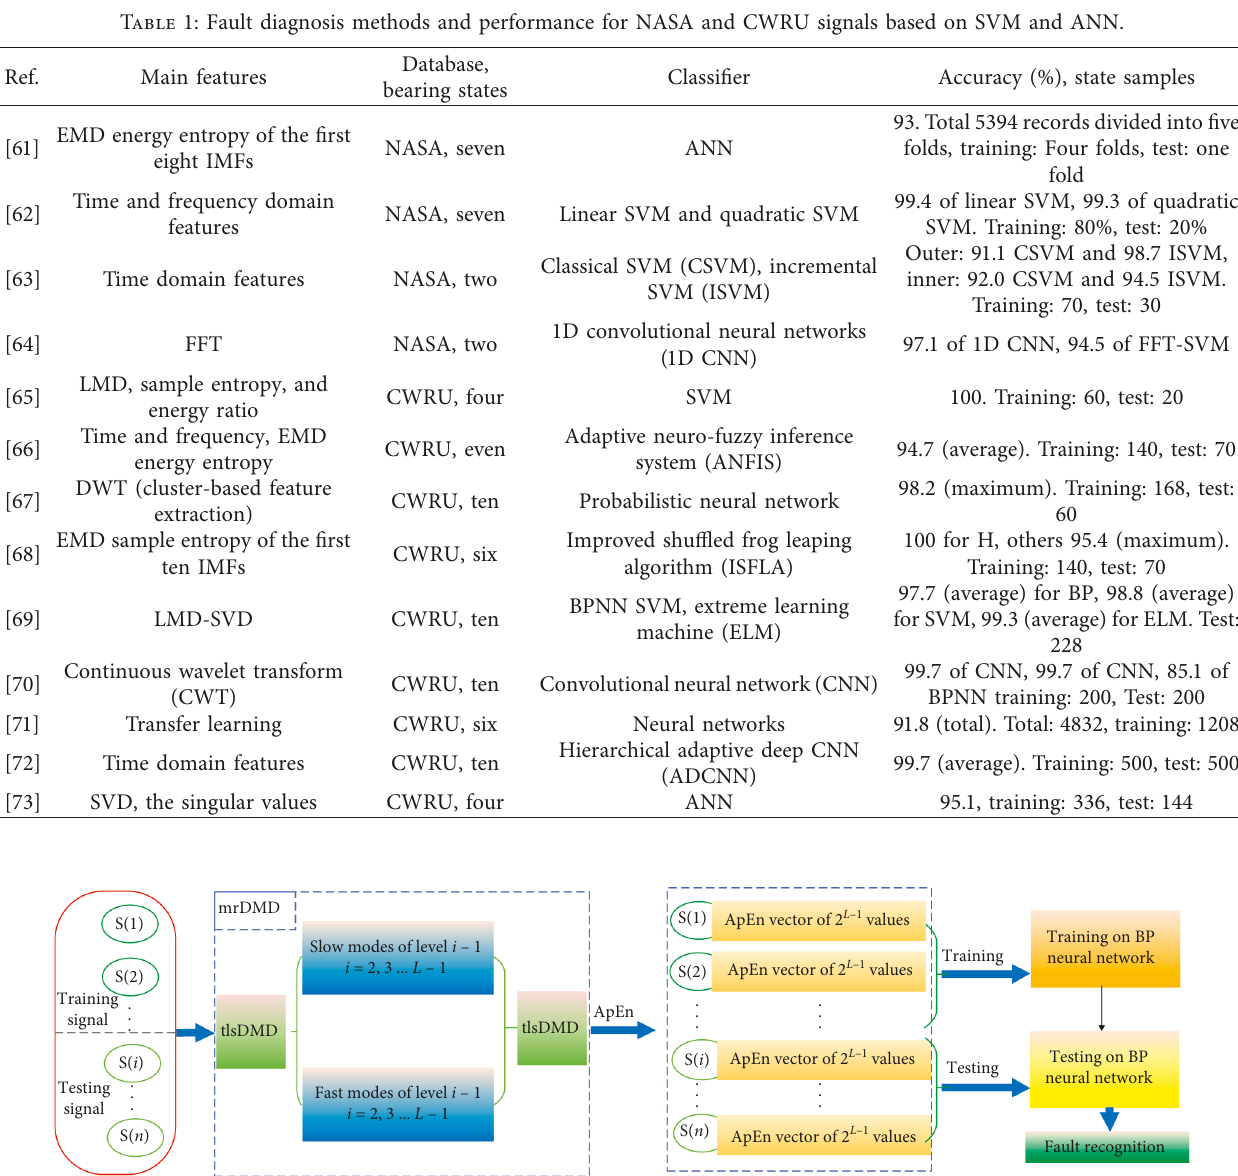
Figure 3: A flowchart of the proposed